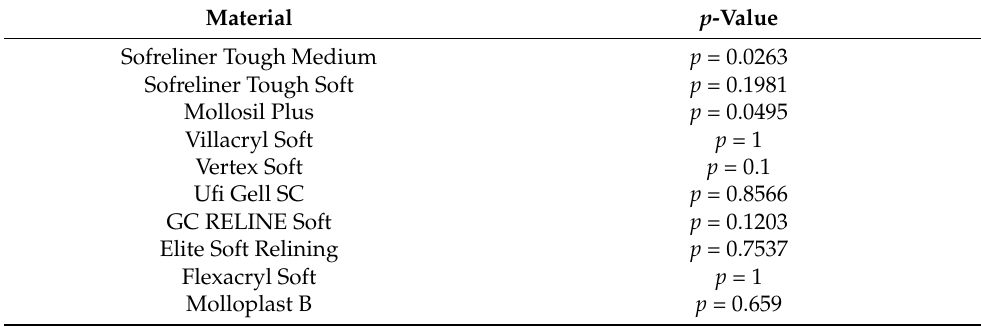
Table 3. The results of statistical analyses of failure types in tensile strength test changes for tested materials after 90-days experiment, α =